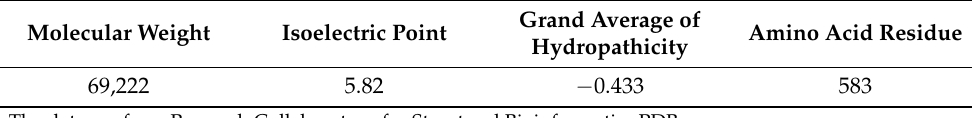
Table 1. The physicochemical properties of BSA 1 .